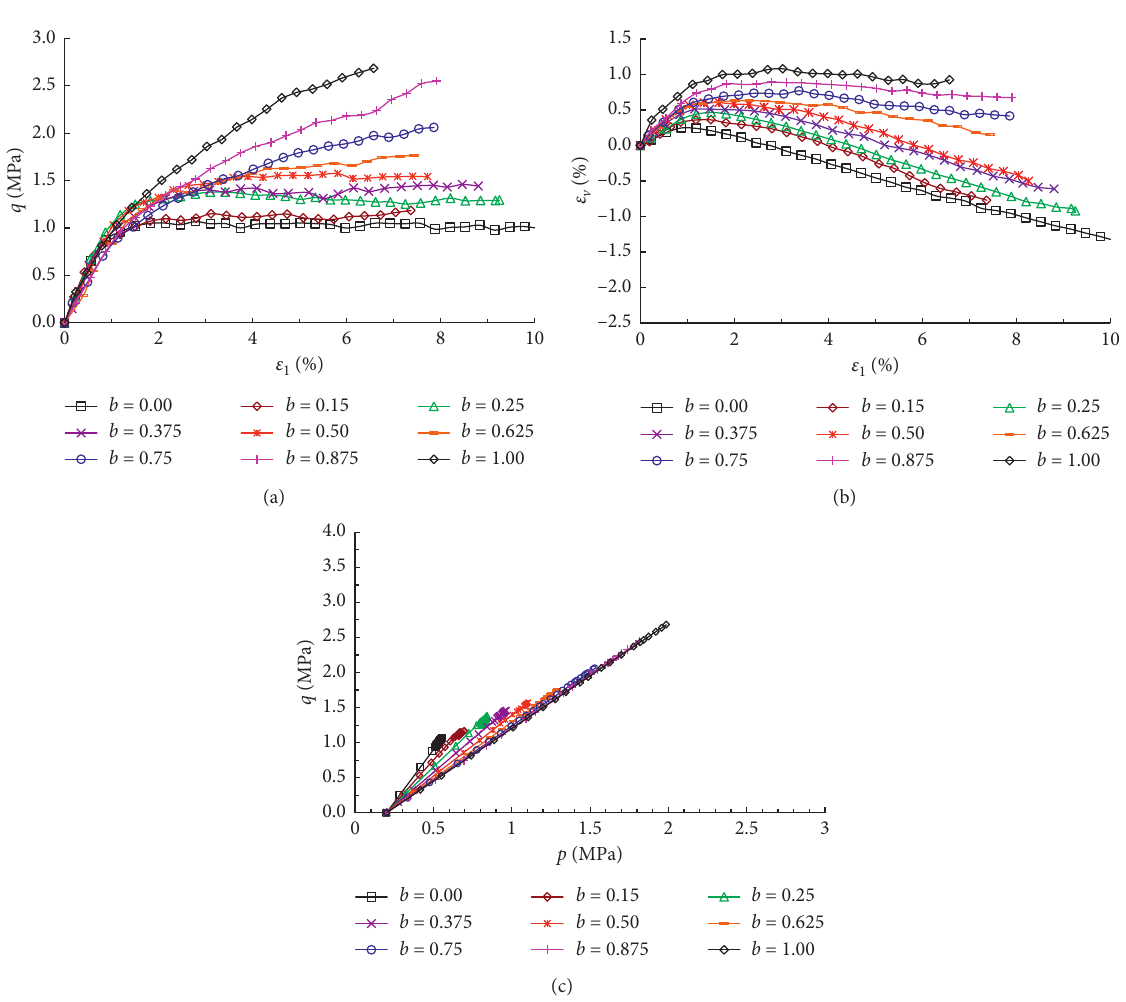
3 and constant b tests at σ 3